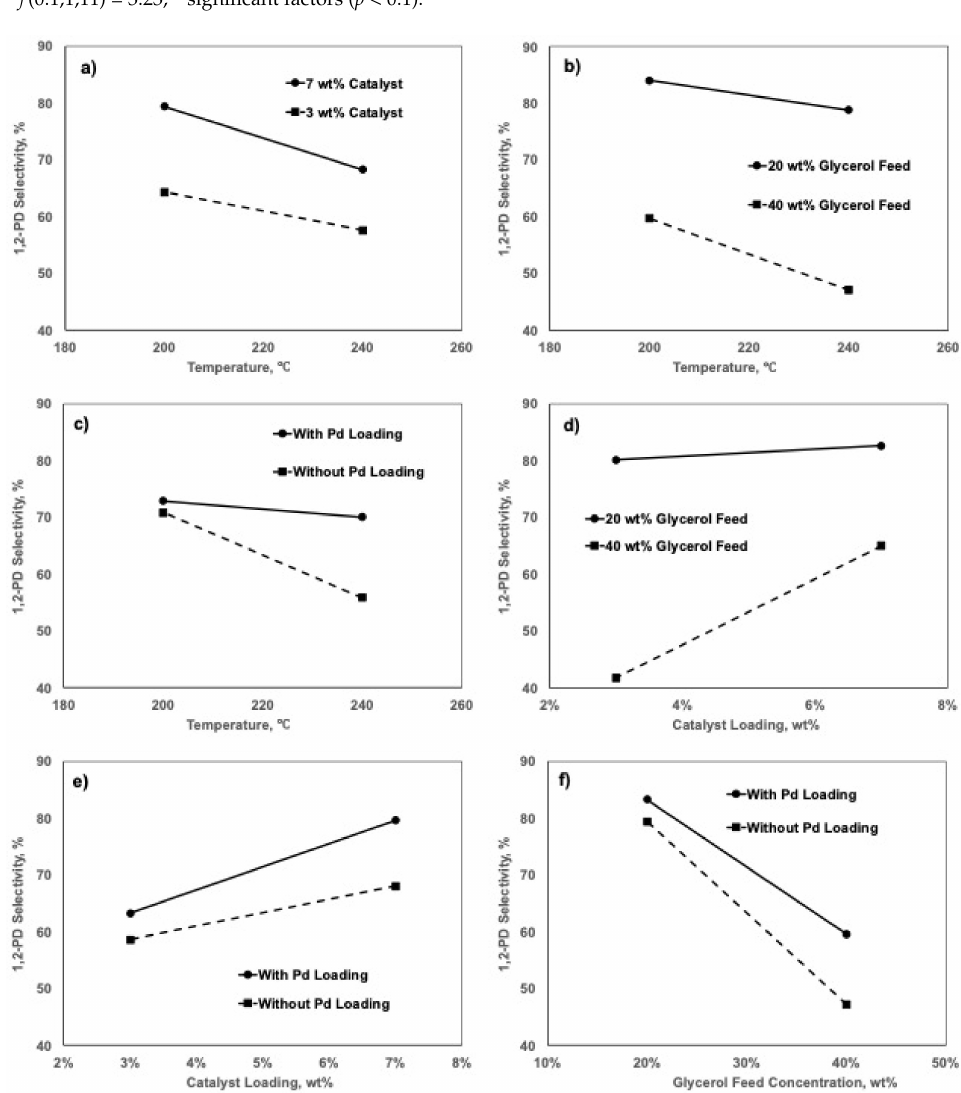
Figure A1. Two factor interactions on the 1,2-PD selectivity. ( a ) AB; ( b ) AC; ( c ) AD; ( d ) BC; ( e ) BD; ( f )